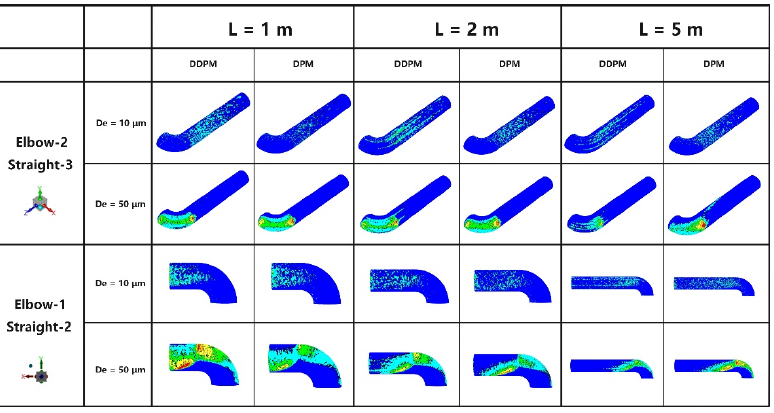
Figure 16. Erosion contours calculated by the DDPM and the DPM. Each pair of rendered colors corresponds to the same erosion range.